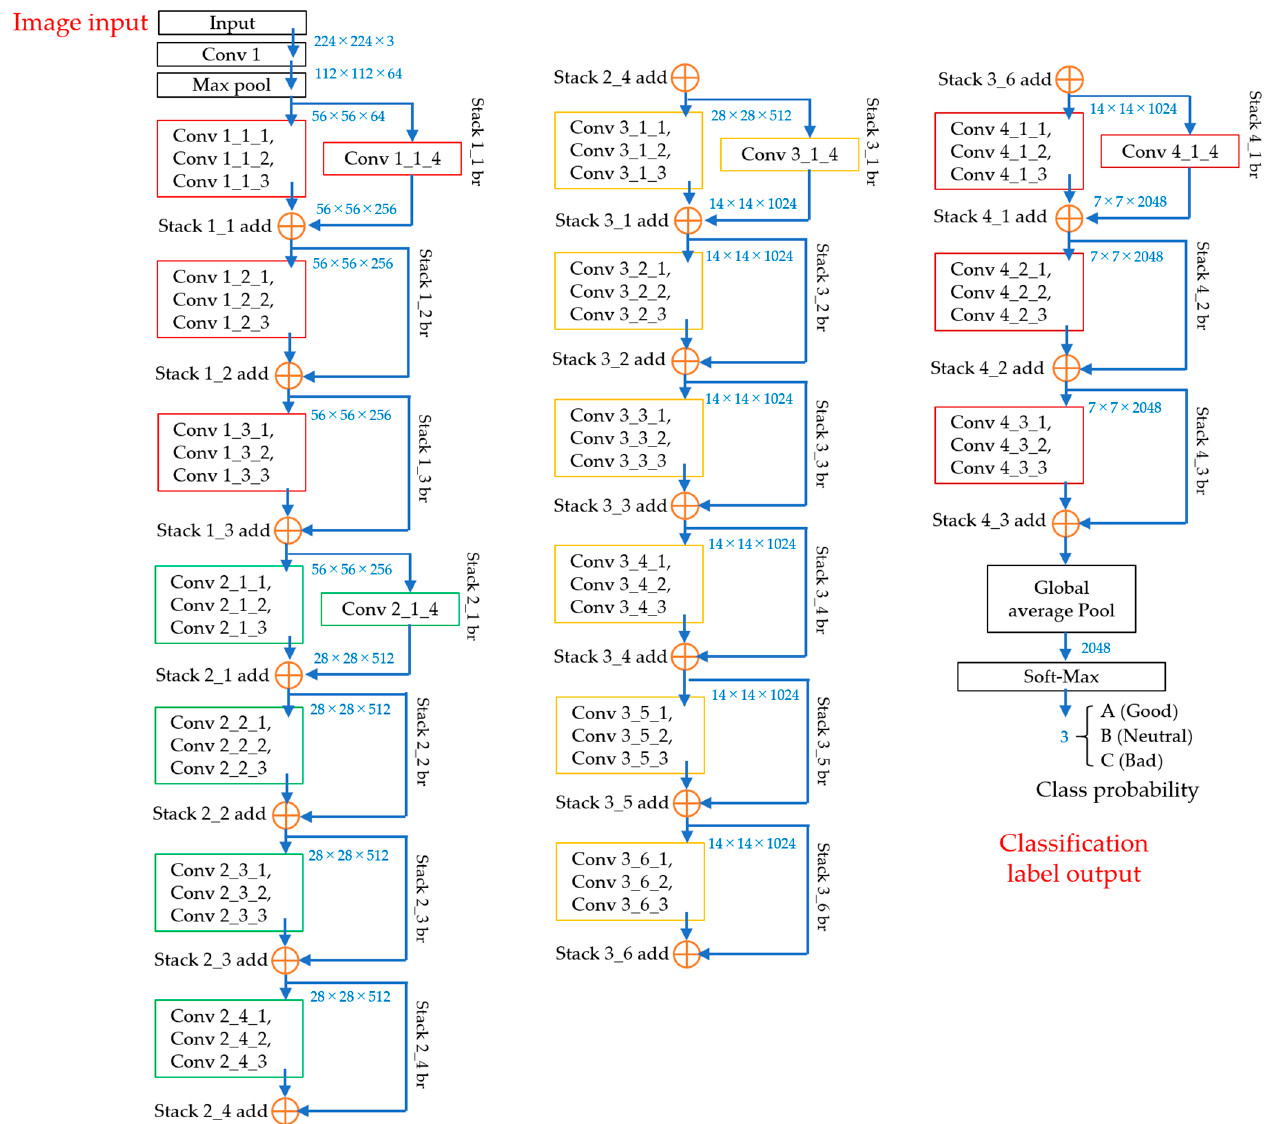
Figure 8. Proposed CNN structure.